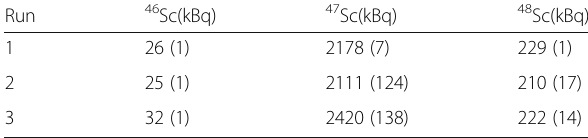
Table 2 The average ( n = 3, 1 σ ) 46,47,48 Sc radioactivity measured in nat Ti discs processed in this